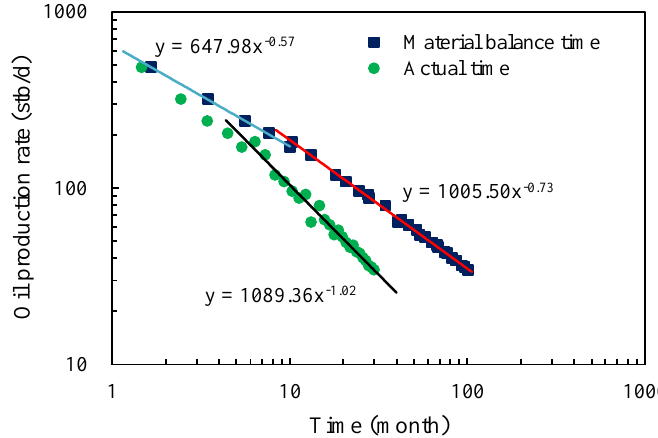
Figure 10. Plot of production rate data for Well #4.